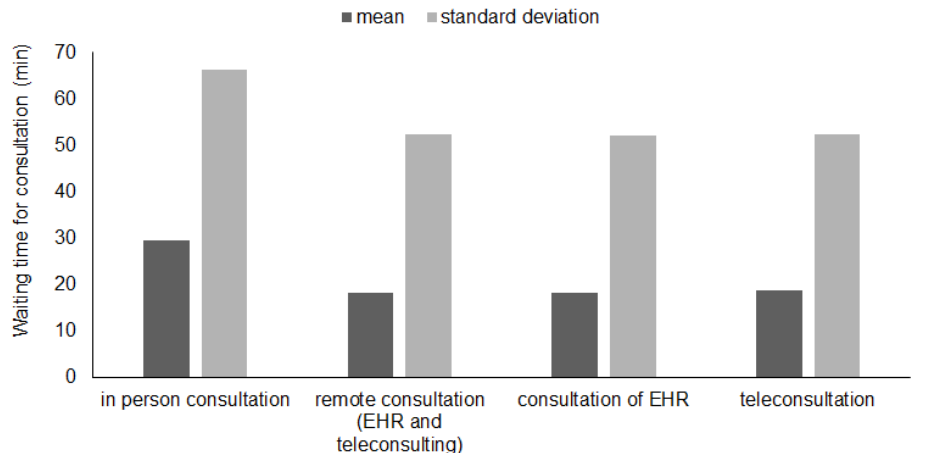
Figure 6. Comparison of average waiting times for each consultation approach before and after improvement.